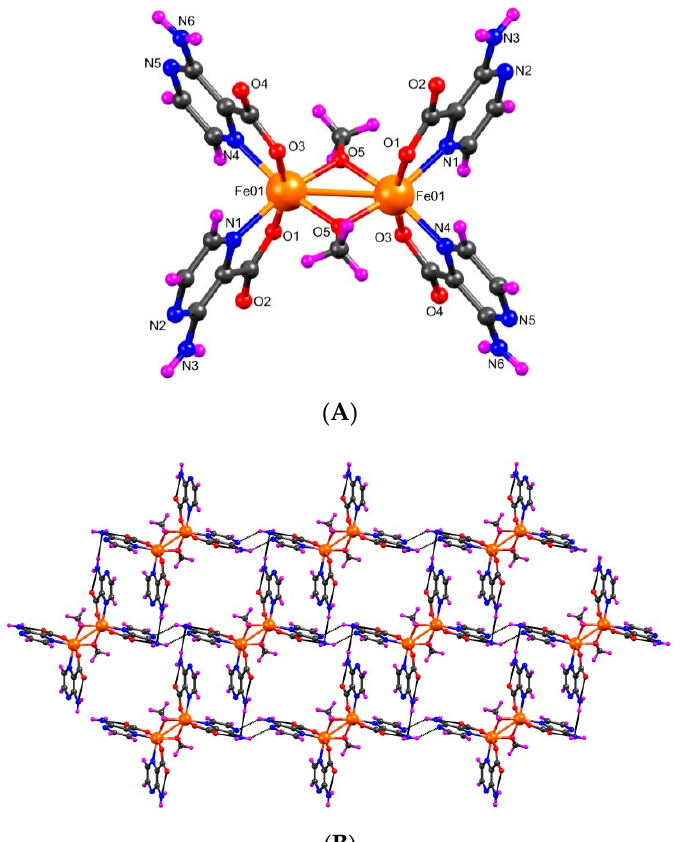
Figure 3. ( A ) Ball-and-stick representation of 3 with partial atom numbering scheme. ( B) Its 2D hydrogen-bonded network.